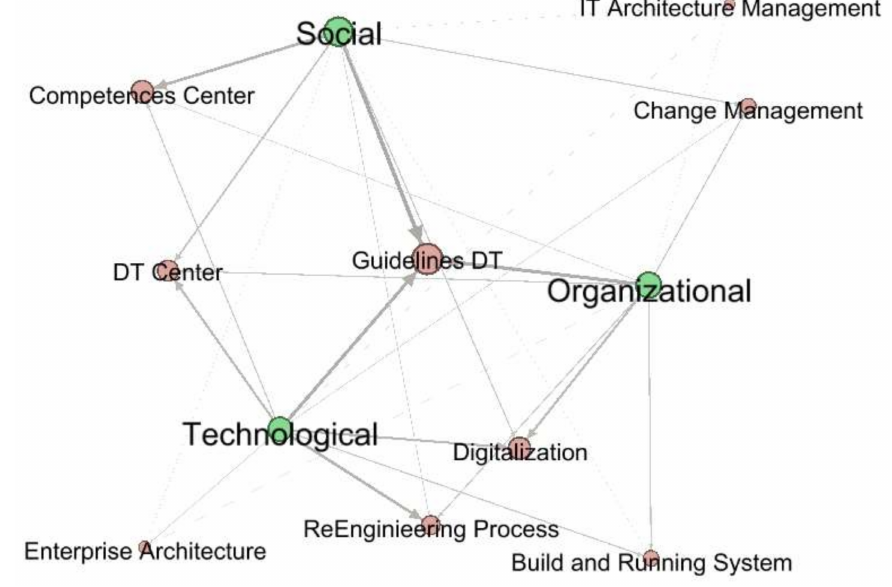
Figure 6. Methods applied in DT in